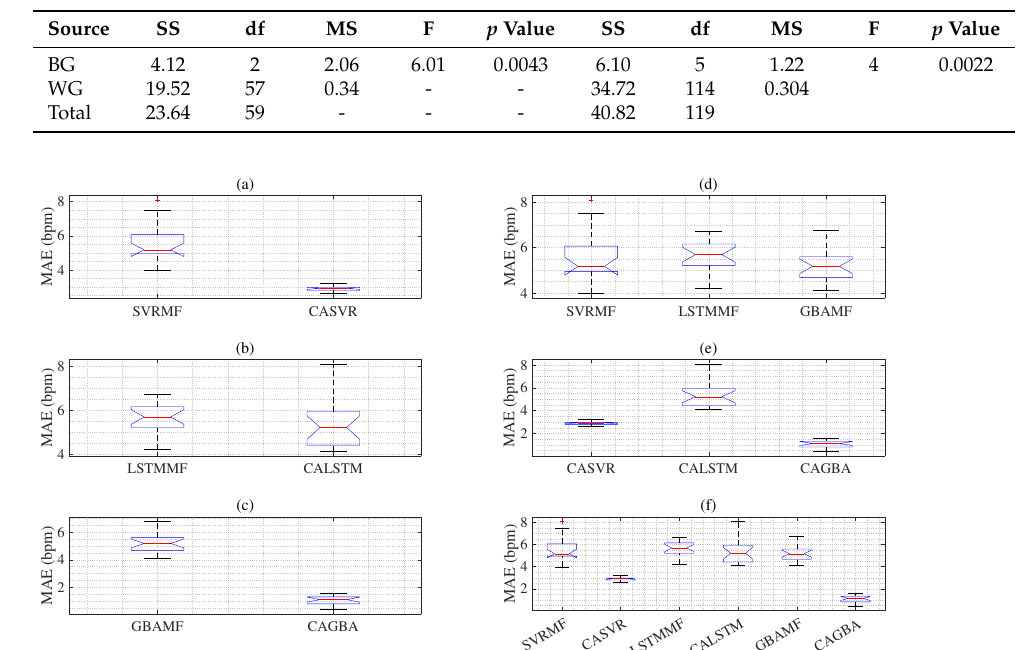
Figure 4. The box below represents the MAE and SD compared to the reference RR method obtained using the RRSYNTH dataset; where ( a ) is the MAE results of SVRMF and CASVR, ( b ) denote the MAE results of LSTMMF and CALSTM, ( c ) is the MAE results of GBAMF and CAGBA, and ( d ) denote the MAE results of SVRMF, LSTMMF, and GBAMF, ( e ) is the the MAE results of CASVR, CALSTM, and CAGBA, and ( f ) is the MAE results of all models.